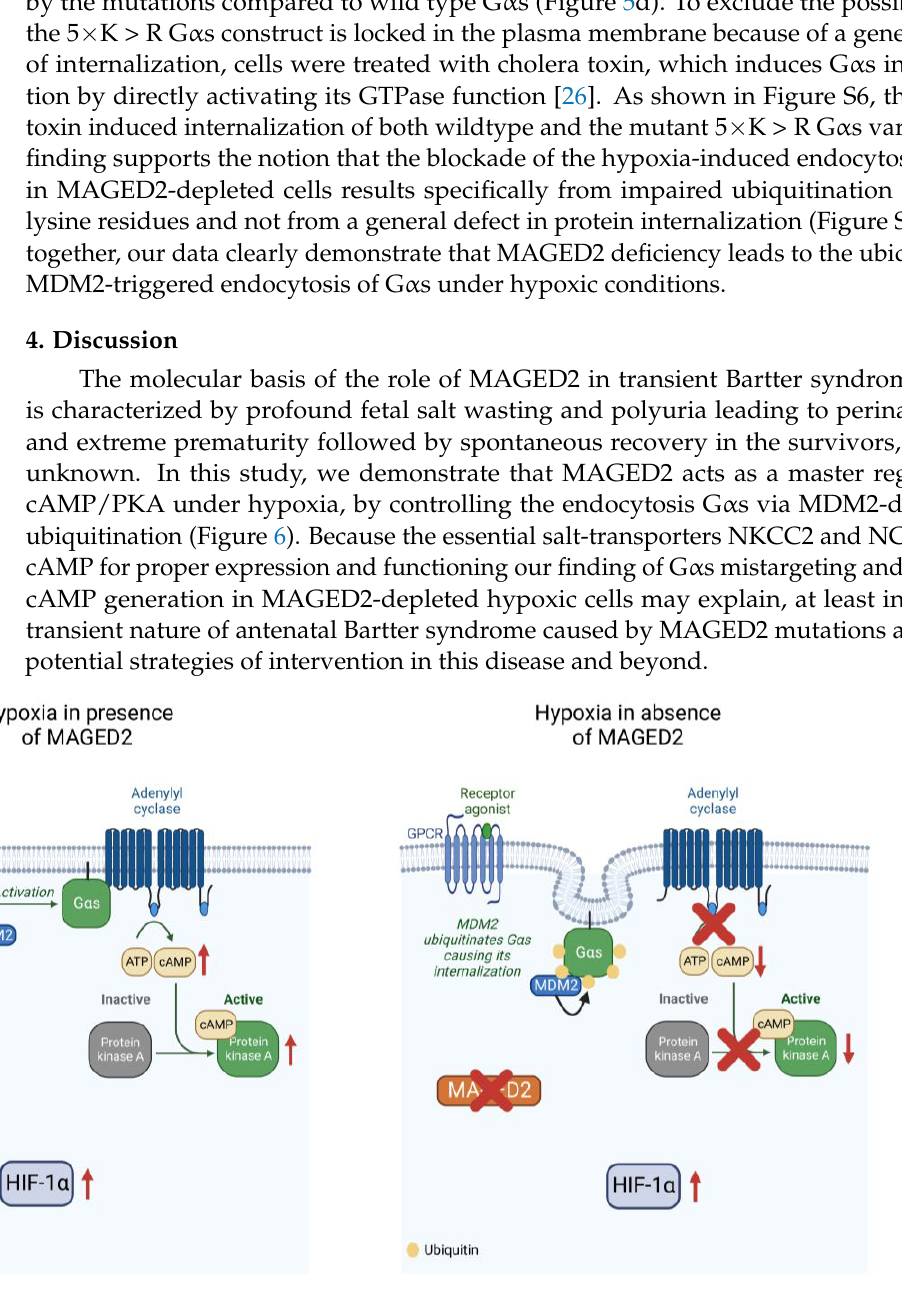
Figure 6. Proposed model for MAGED2′s role under hypoxia (created with BioRender.com). Under hypoxia, MAGED2 inhibits MDM2 dependent ubiquitination and endocytosis of Gαs. This ensures activation of the adenylate cyclase and cAMP generation and activation of PKA under hypoxia. Reduced cAMP levels impair cAMP-dependent salt reabsorption, explaining salt wasting in transient Bartter syndrome.